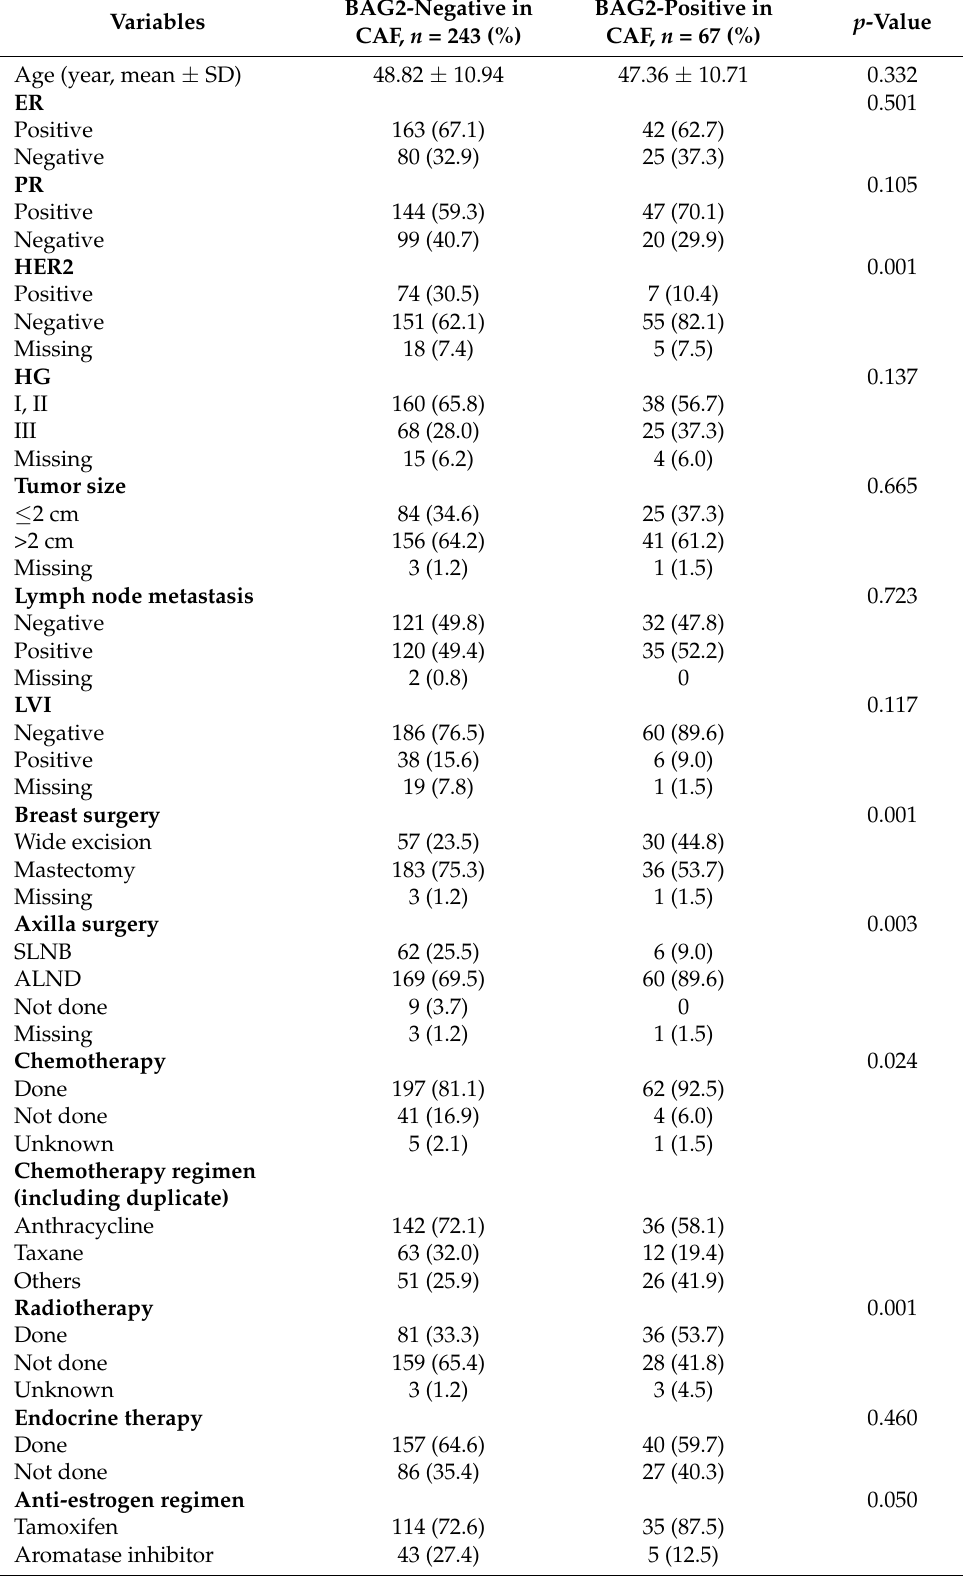
Table 1. Clinical characteristics according to BAG2 expression in cancer-associated fibroblast